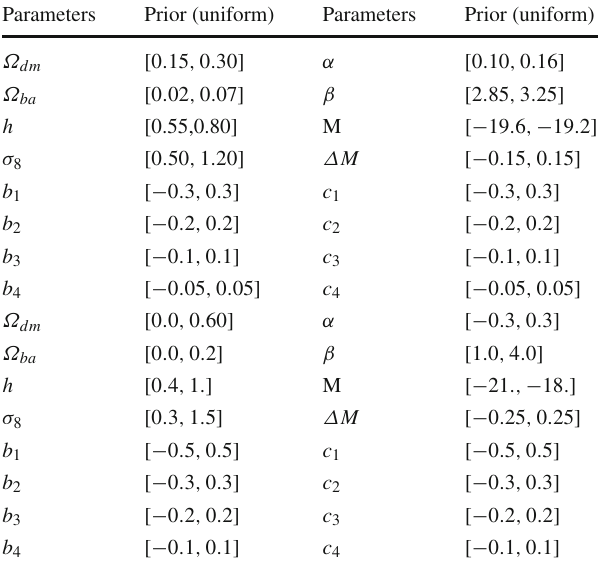
Table 3 Two ranges of the model parameters which we consider in this work. The upper panel (lower panel) indicates a narrow(broad) prior Parameters Prior (uniform) Parameters Prior